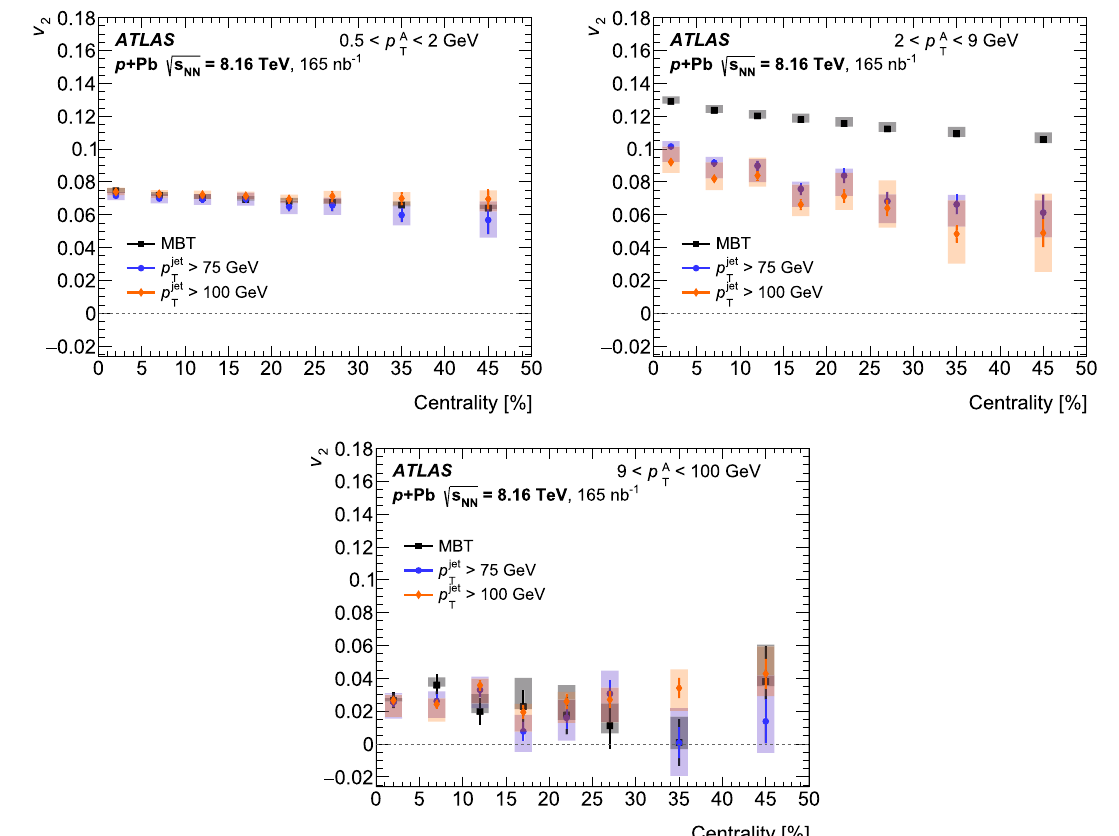
Fig. 5 Distribution of v 2 plotted as a function of centrality for MBT events (black squares), events with jet p T > 75 GeV (blue cir- cles), and events with jet p T > 100 GeV (orange diamonds). The results are obtained in three different selections of the A-particle p T :